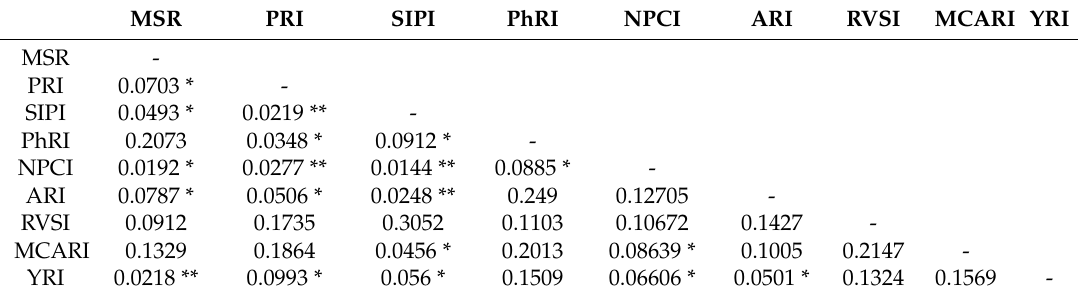
Table 5. Results of ANOVA between selected